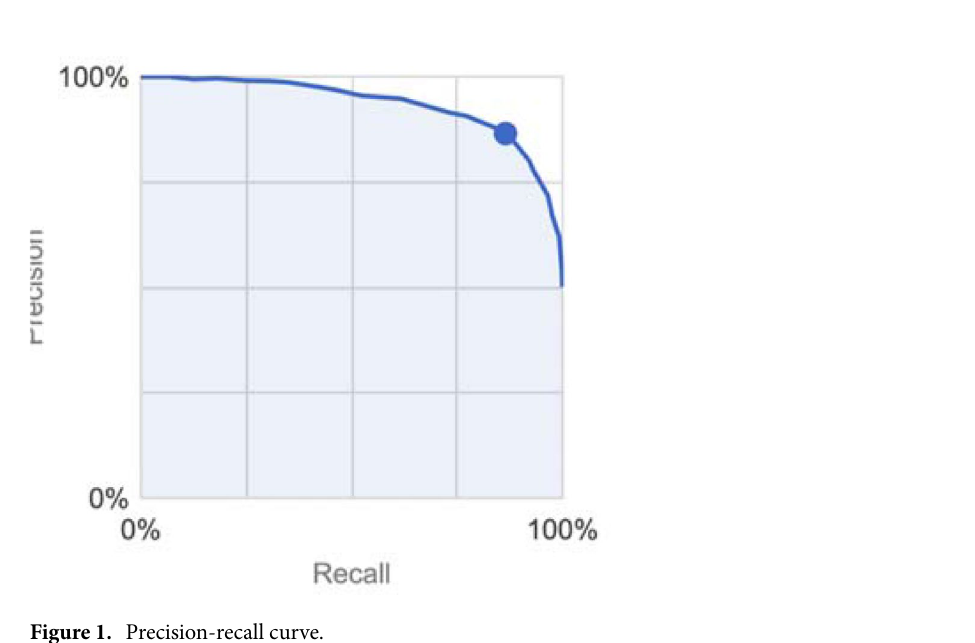
Figure 1. Precision-recall